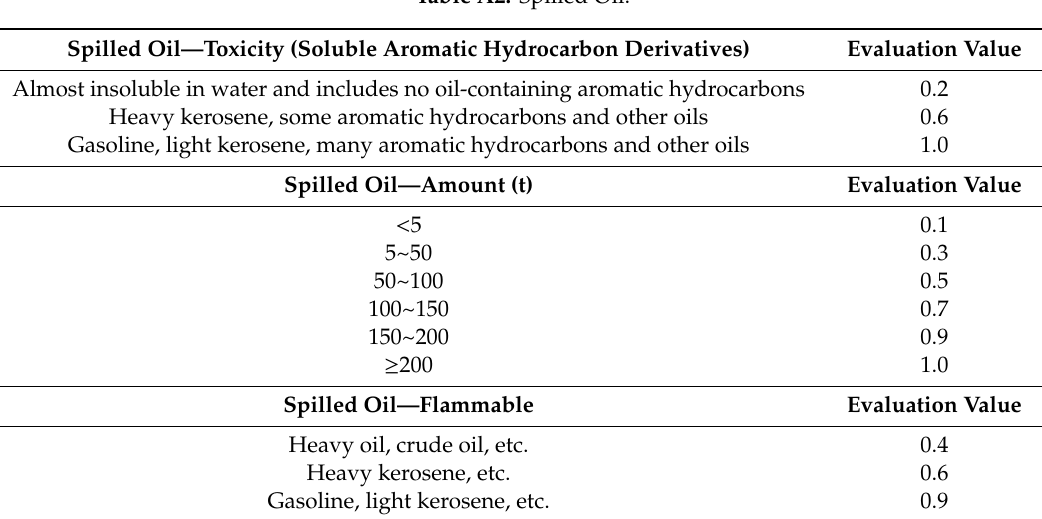
Table A2. Spilled Oil.